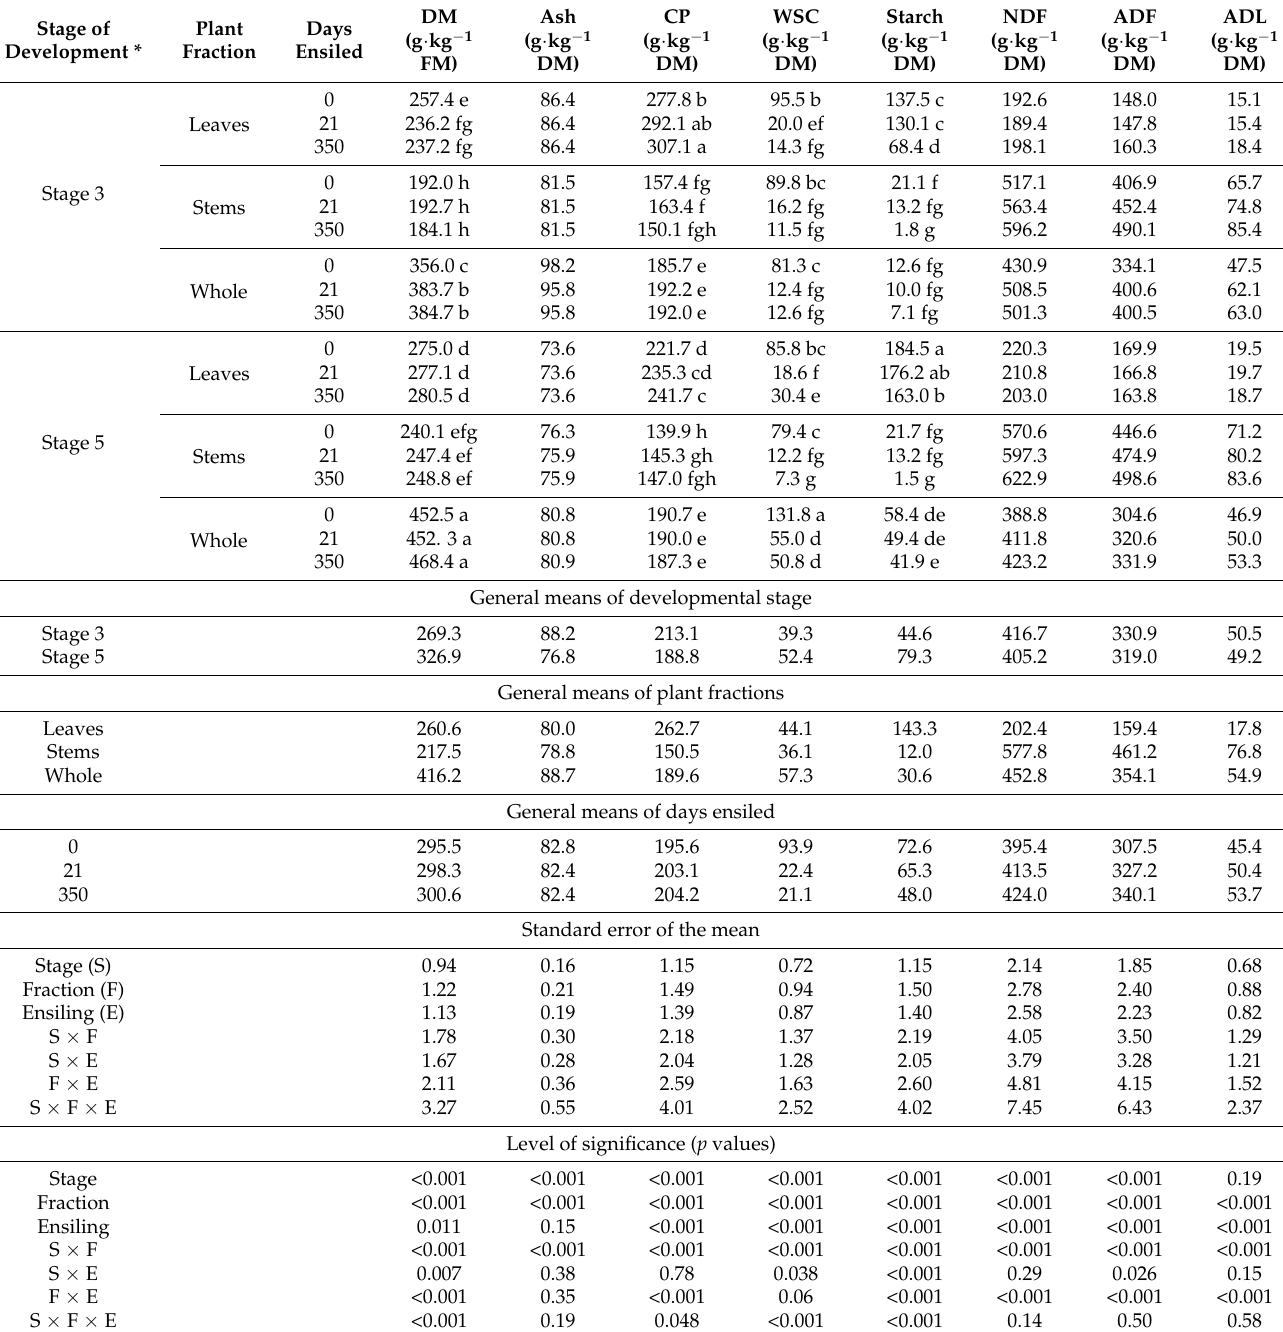
Table 1. Nutrient composition of alfalfa leaf, stem, and wilted whole-plant silages at two developmental stages before and after